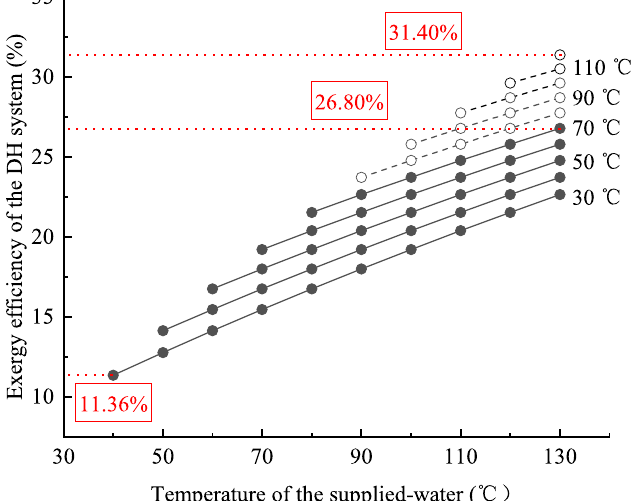
Figure 7. Influences of returned- and supplied-water temperatures on η ex